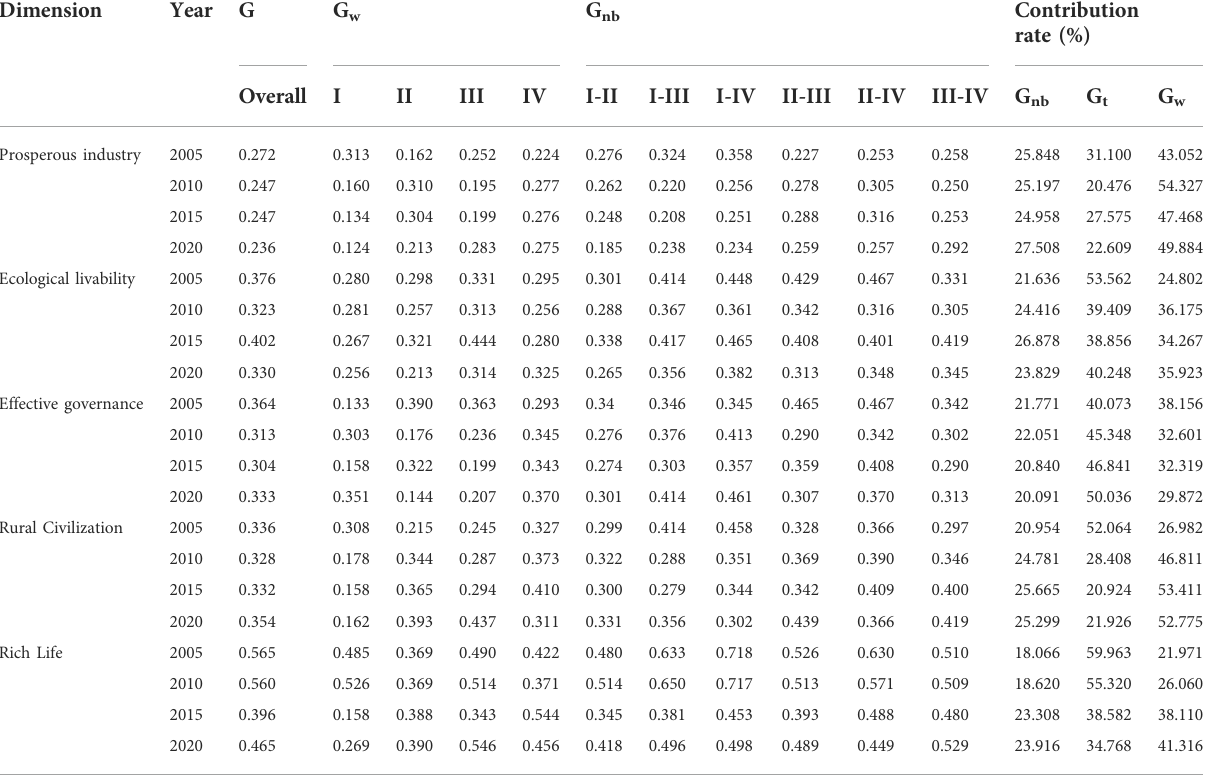
TABLE 10 Regional difference data results of 31PLAD based on Dagum.